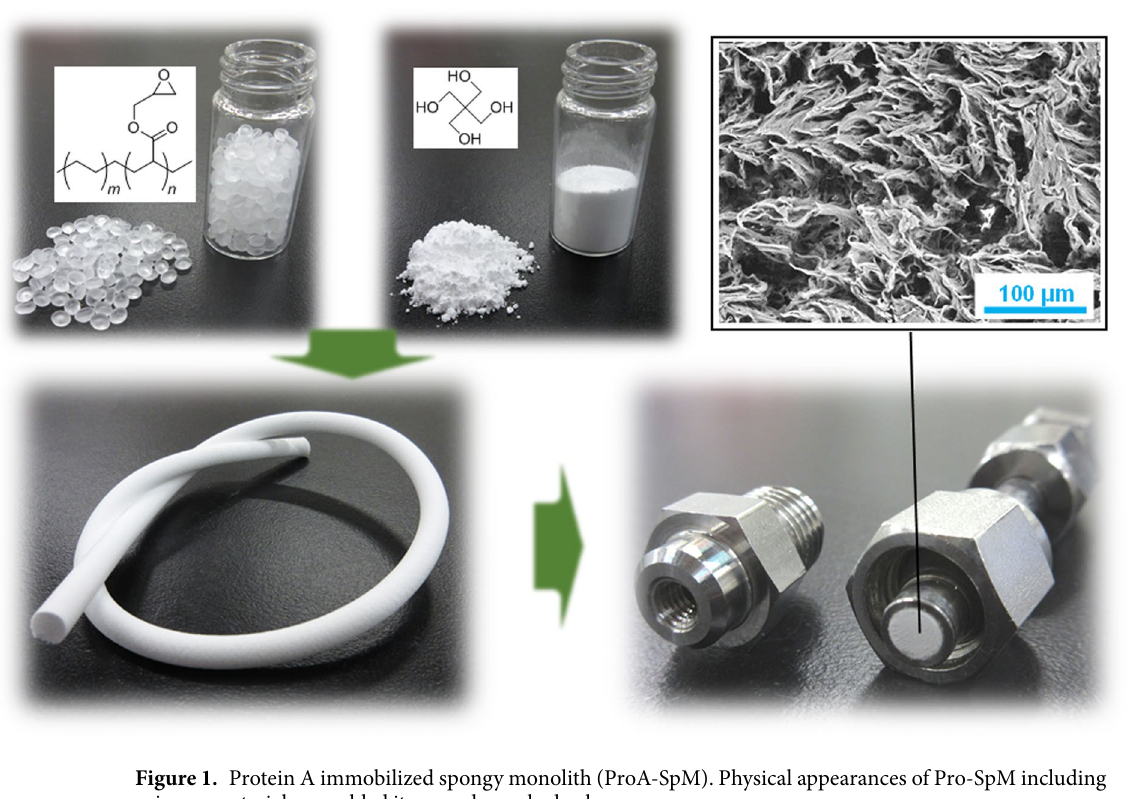
Figure 1. Protein A immobilized spongy monolith (ProA-SpM). Physical appearances of Pro-SpM including primary materials, a molded item, and a packed column.